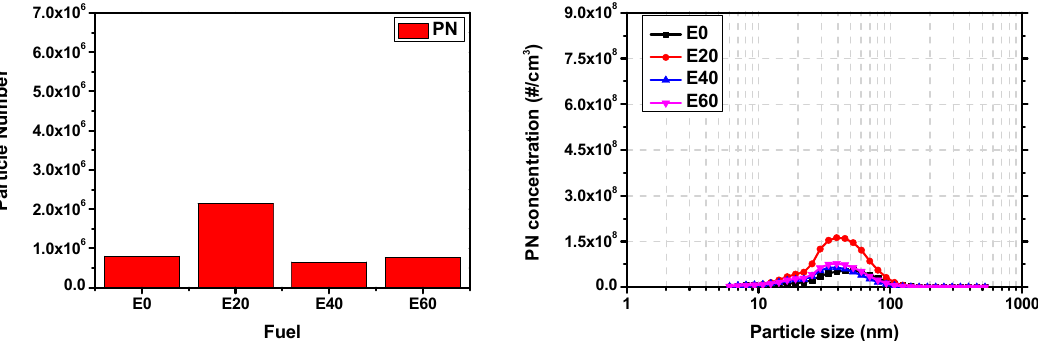
Figure 13. Particle number and size distribution for ethanol blending ratio in over-square engine.